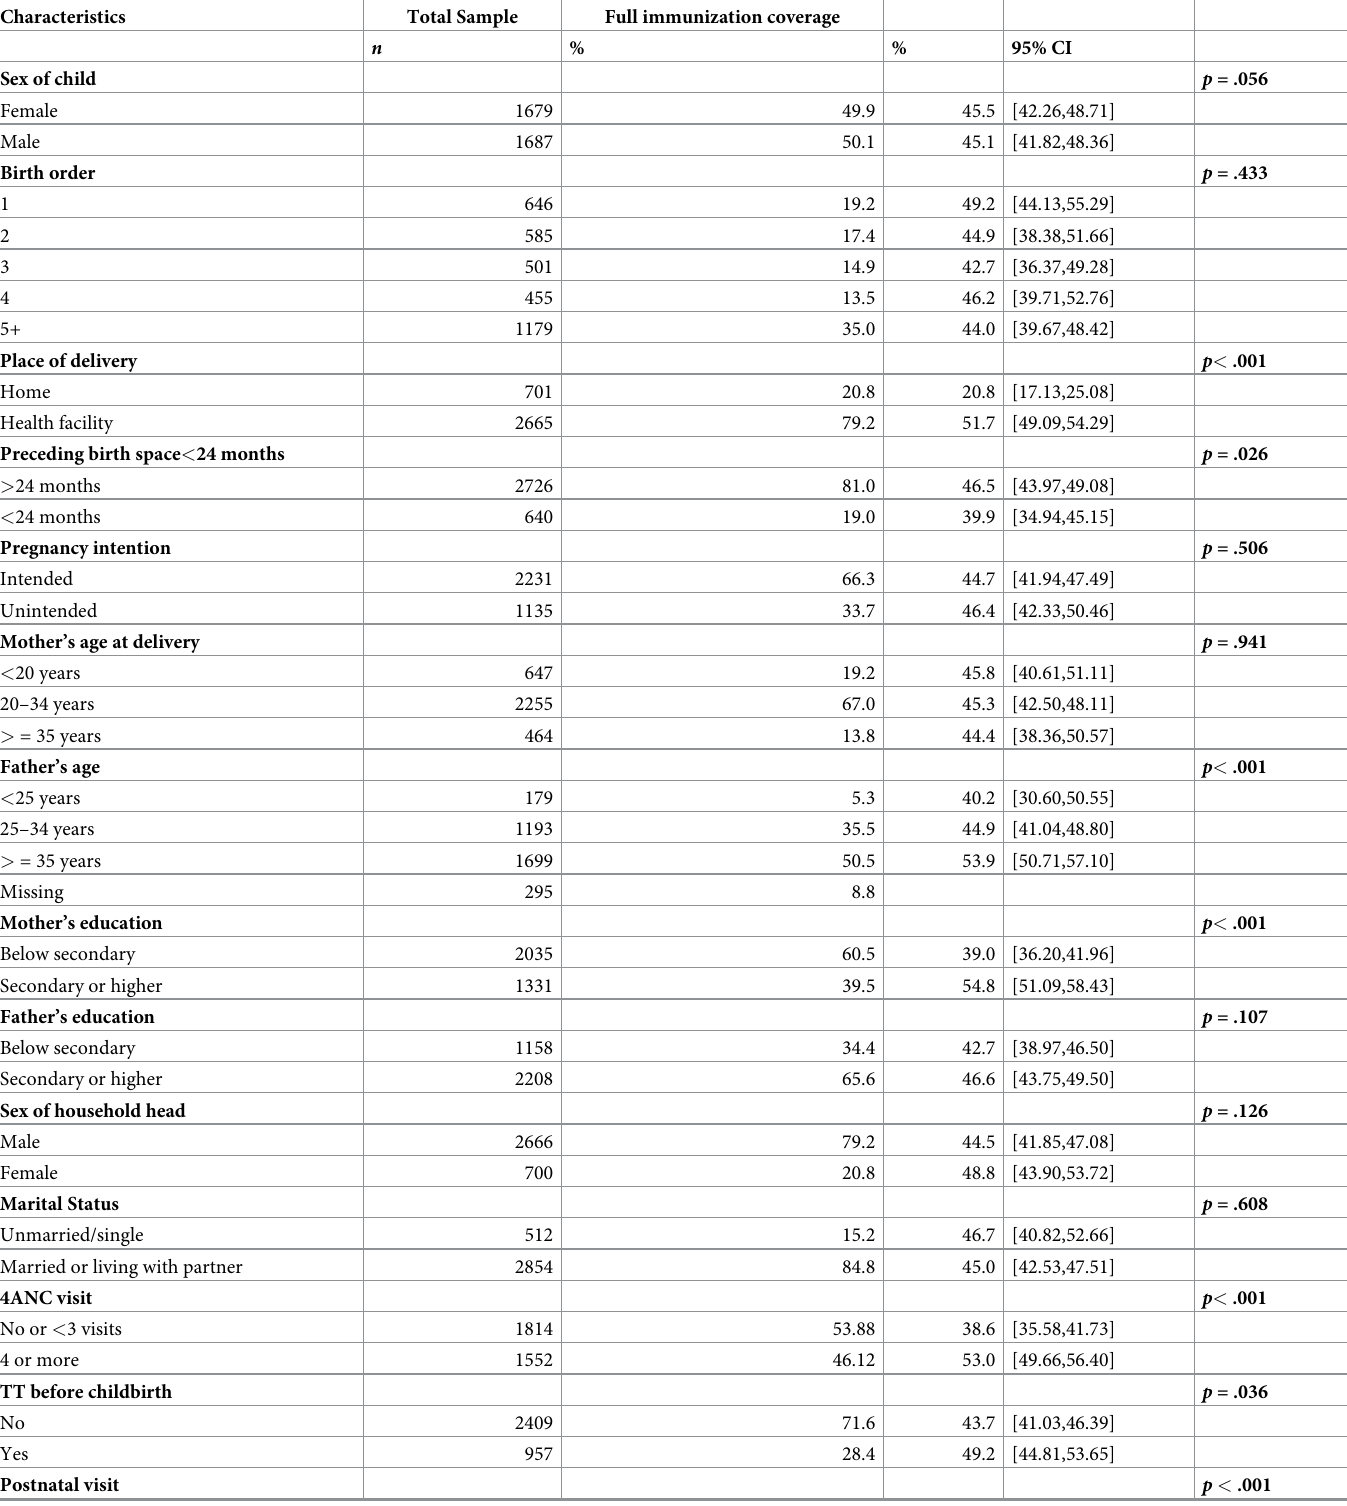
Table 2. Immunization coverage among 12–23-month-old children according to individual-level background characteristics in the DRC in 2013–14 ( n = 3,366).